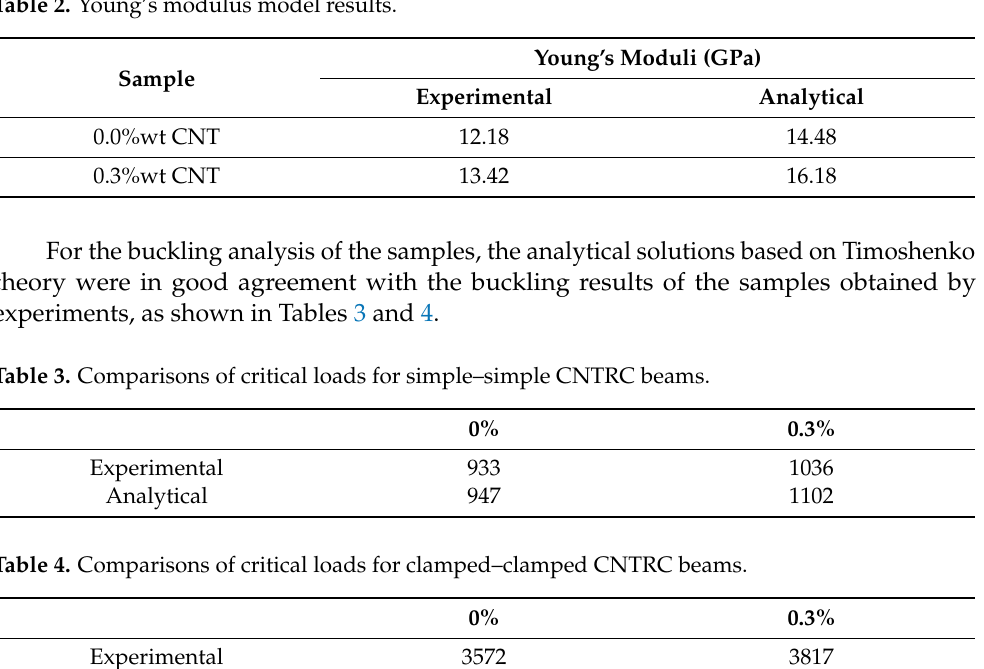
Table 2. Young’s modulus model results.